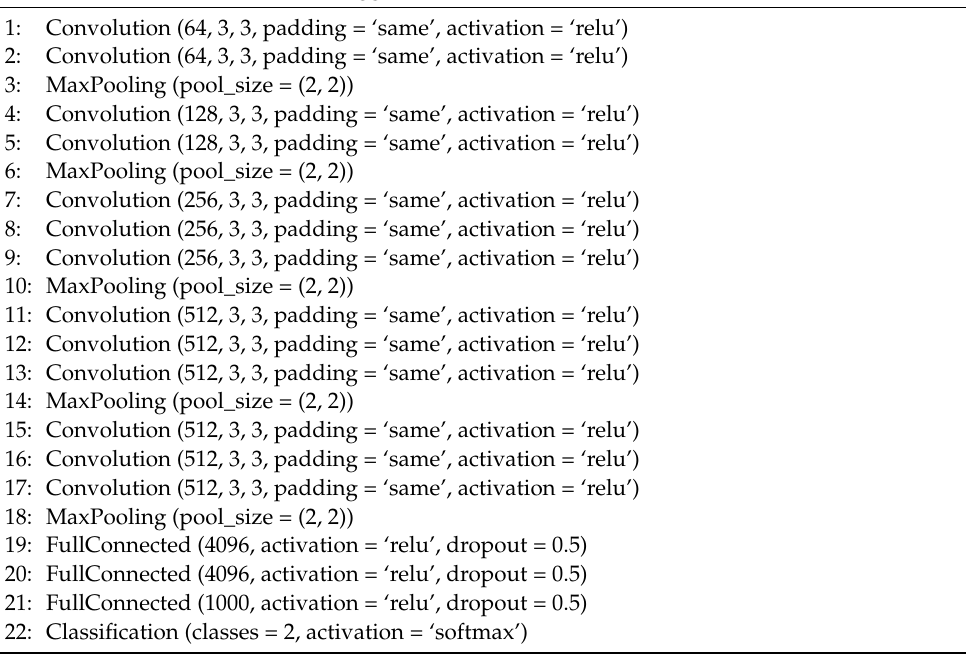
Algorithm 3 CNN architecture of VggNet